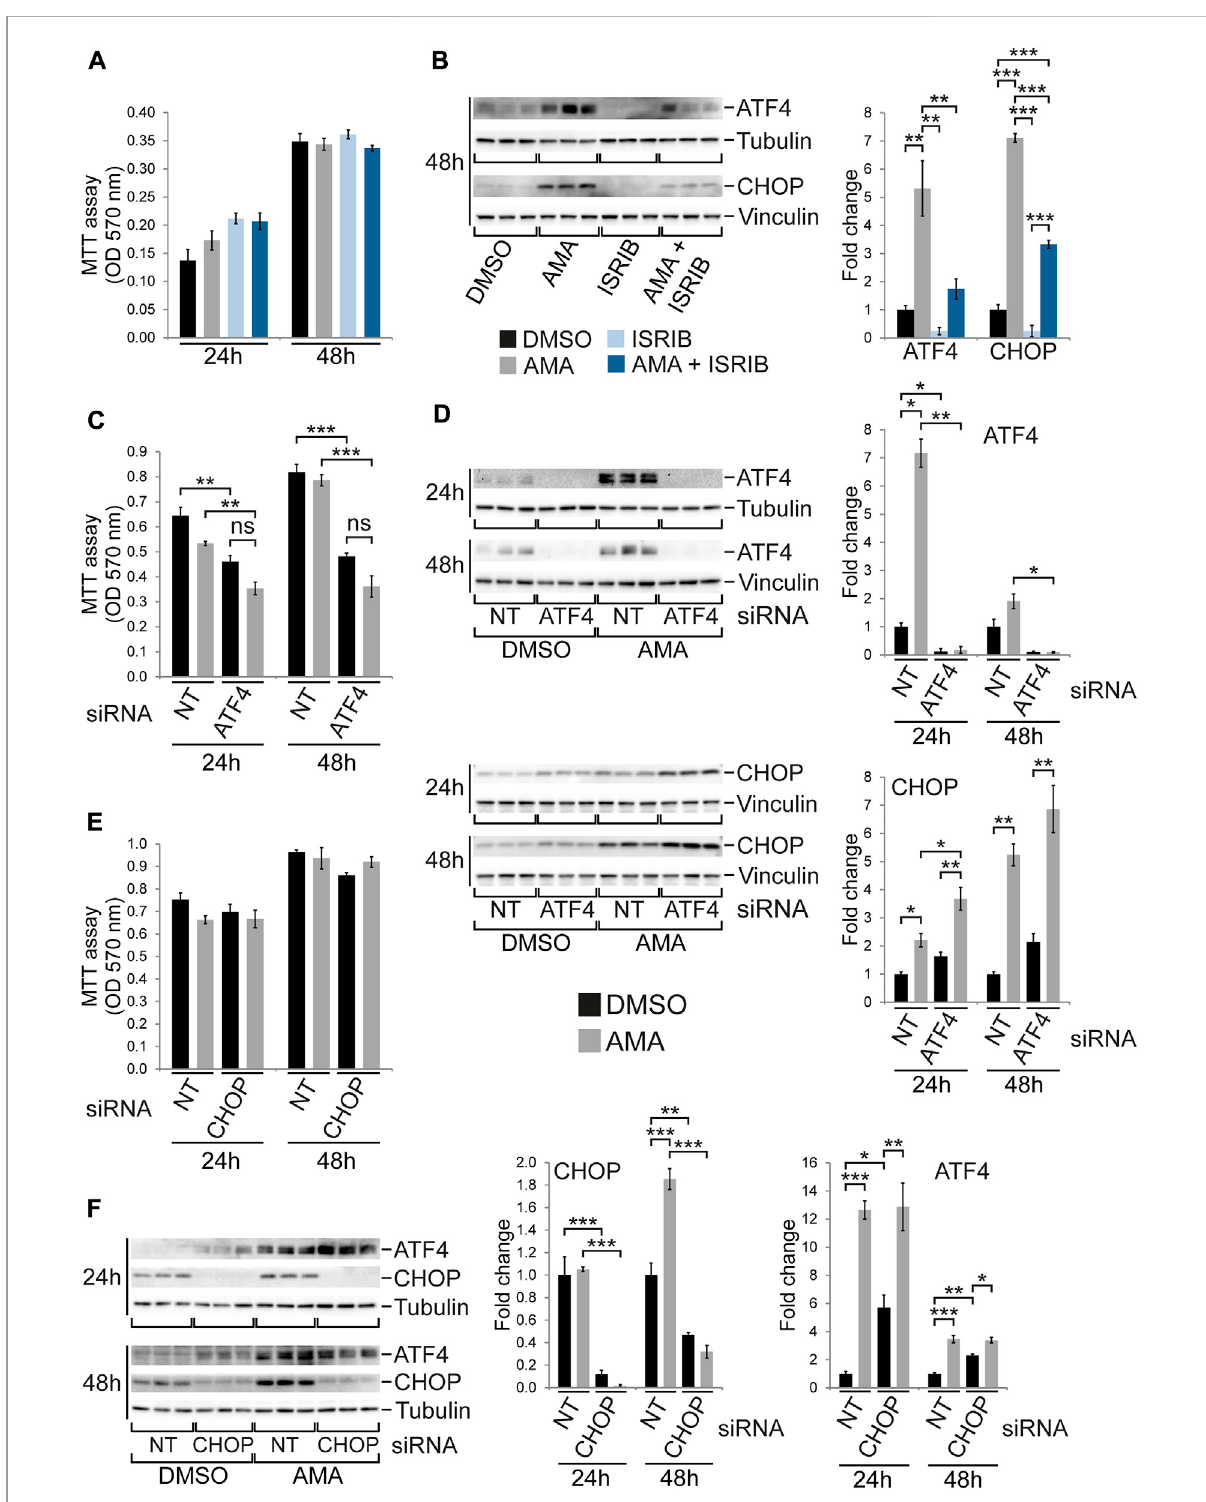
The ISR isnot required for growth and survivalof H9c2cells upon antimycin Atreatment. (A) MTT assays ofH9c2 cells treatedwith DMSO, AMA (50 µM), ISRIB (200 nM) or a combination of AMA and ISRIB for 24 and 48 h. (B) Western blots showing protein expression of the ISR components ATF4 and CHOP after 48 h treatment as outlined in (A) [ n = 3 wells per treatment in (A) and (B) ]. (C) MTT assays of H9c2 cells transfected with non- target(NT)orATF4siRNAandsubsequentlytreatedwithDMSOorAMAfor24and48 h. (D)